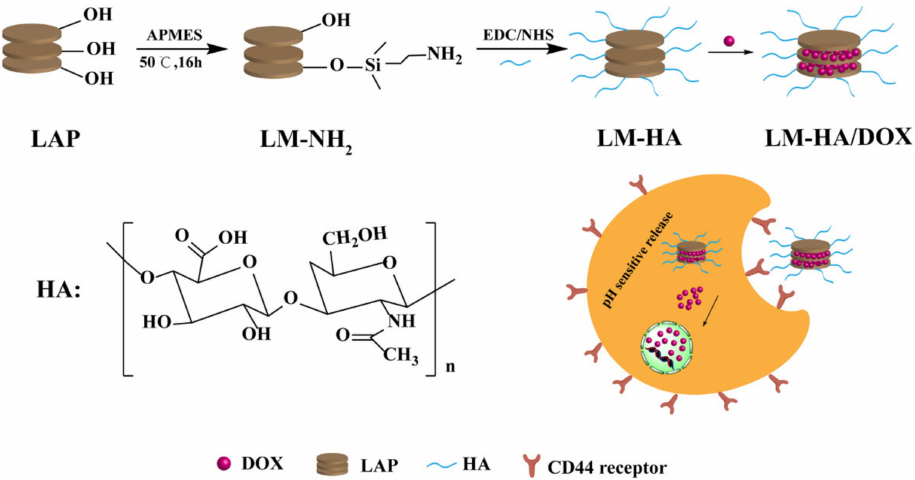
Scheme 1. Schematic illustration of the preparation of